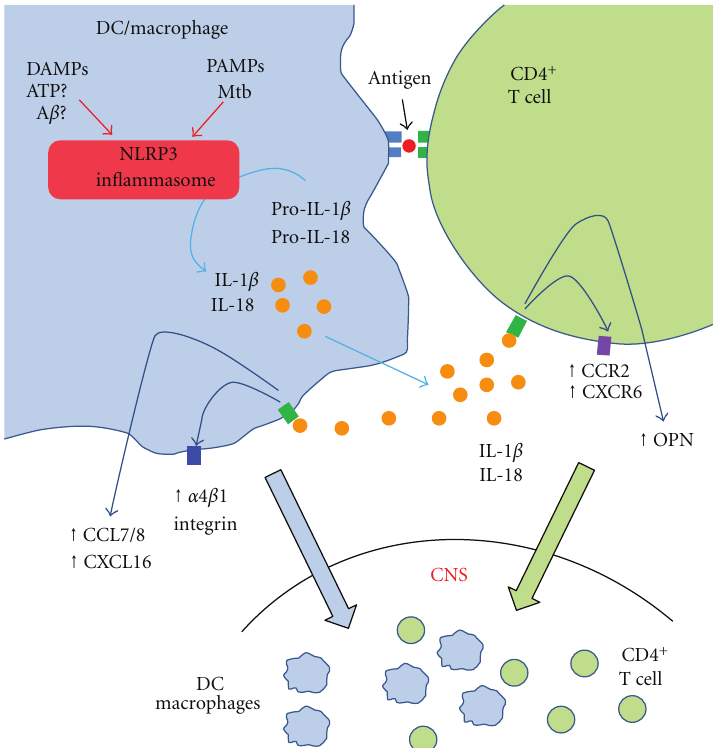
F 2: Role of NLRP3 in�ammasome in the development of the autoimmune responses in EAE. Upon activation by DA�Ps and